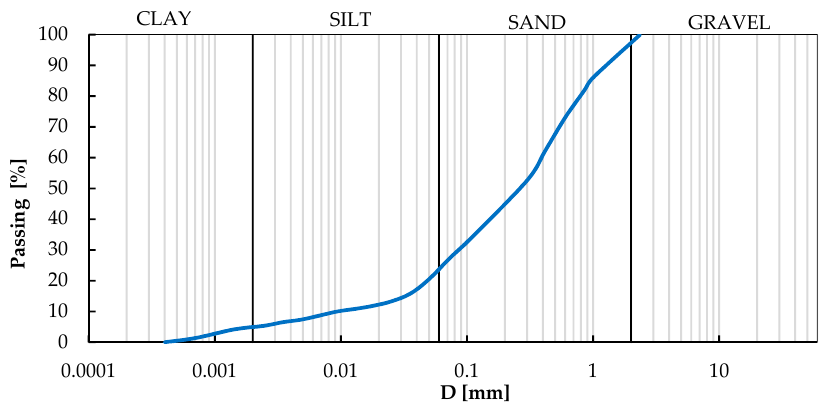
Figure 8. Grain size distribution for soil tested. The soil is a silty sand.